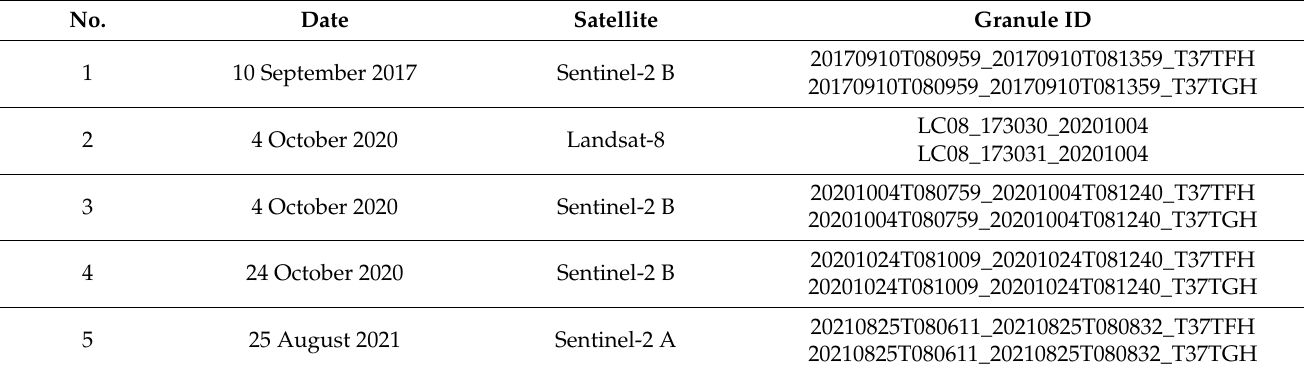
Table 2. The specifications of the satellite images